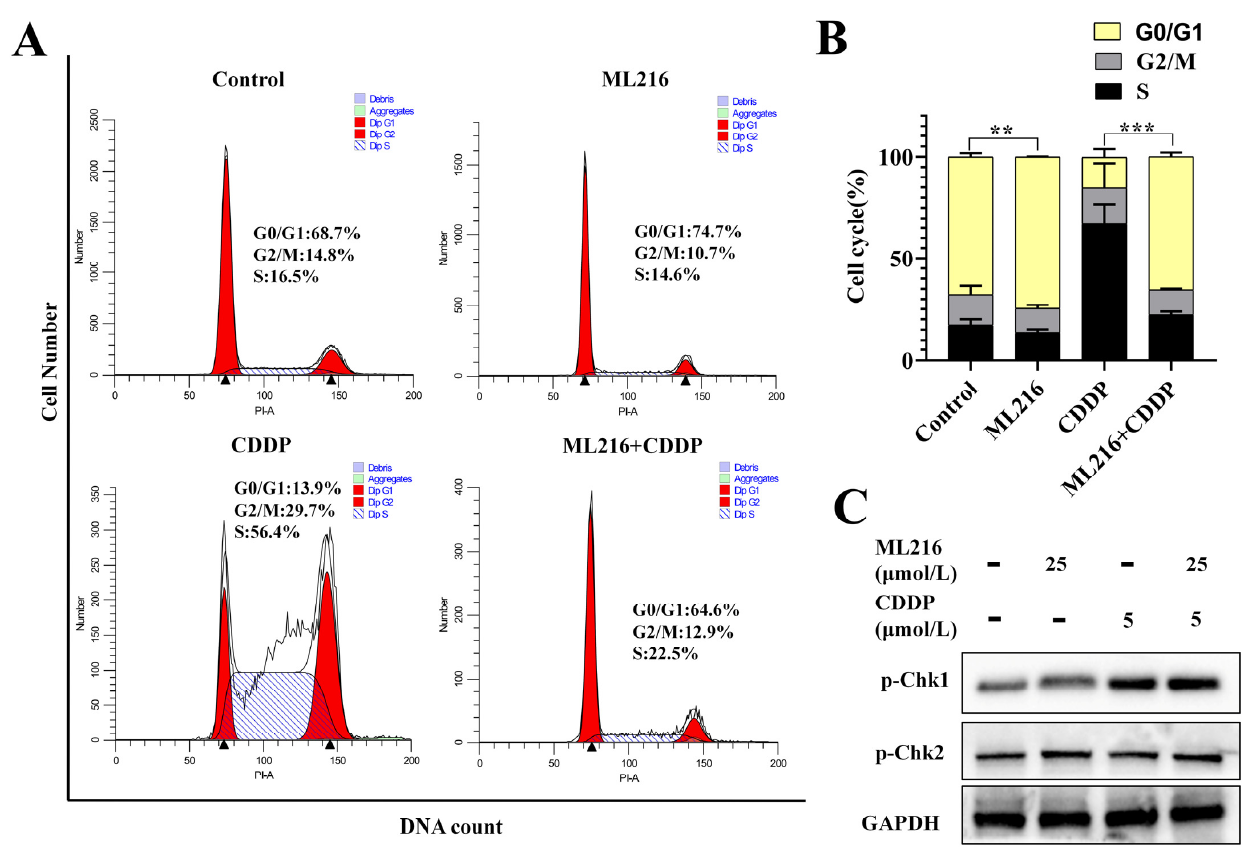
Figure 5. The combination of ML216 and CDDP activates ATM/Chk2 and ATR/Chk1 signaling. ( A ) Flow cytometry was used to detect the cell cycle distribution of PC3 cells after 48 h of treatment with ML216 (10 μ M), CDDP (1 μ M), or both. ( B ) The percentage of PC3 cells in G0/G1, S, and G2/M phases. The data were presented as mean ±SD. ( C ) The WB was used to analyze the protein levels of p-Chk1 and p-Chk2 in PC3 cells; GAPDH was used as a loading control.